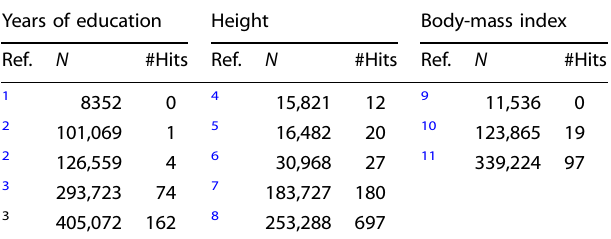
Table 1. Sample size and number of genome-wide signi fi cant associations